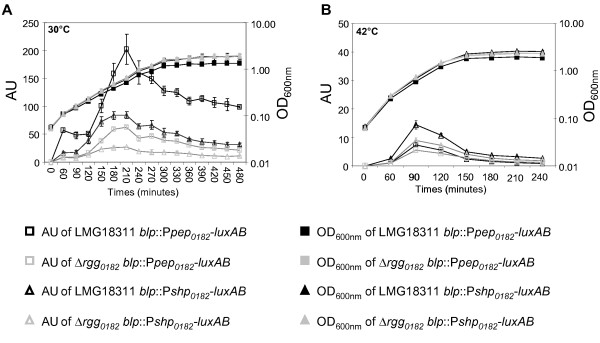
Luciferase activity and growth of the LMG18311 and the Δrgg0182 strains containing the Pshp0182-luxAB and Ppep0182-luxAB transcriptional fusions, in CDM medium. The expression of the fusions was followed in strains cultivated in CDM medium, at 30°C (A) or at 42°C (B). Data are presented as the mean +/- standard deviation of three independent experiments. AU: luminescence arbitrary units normalized against the OD600nm of the cultures.